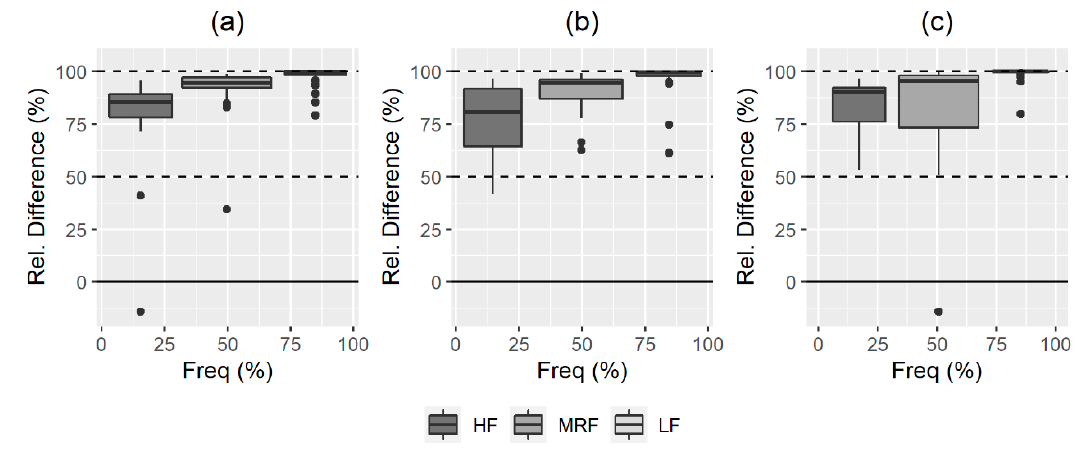
Figure 5. Percentage of reduction per class of flow for gauges ( a ) RD025 / 56610000, ( b ) RD029 / 56659998, and ( c ) RD031 / 56696000. HF, high flows, MRF, Mid-range flows, LF, low-flows.